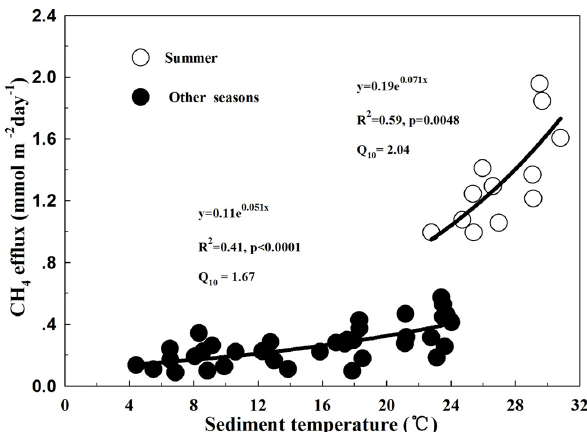
Figure 6. Relationship between sediment temperature and CH 4 ef- fluxes in Poyang Hu. White circles represent the observed values of the diurnal mean CH 4 effluxes and sediment temperature in sum- mer, and black circles represent the observed values of the diurnal mean CH 4 effluxes and sediment temperature in the other seasons in the 4-year period. Black lines represent the fitting curves of the relationship between CH 4 effluxes and sediment